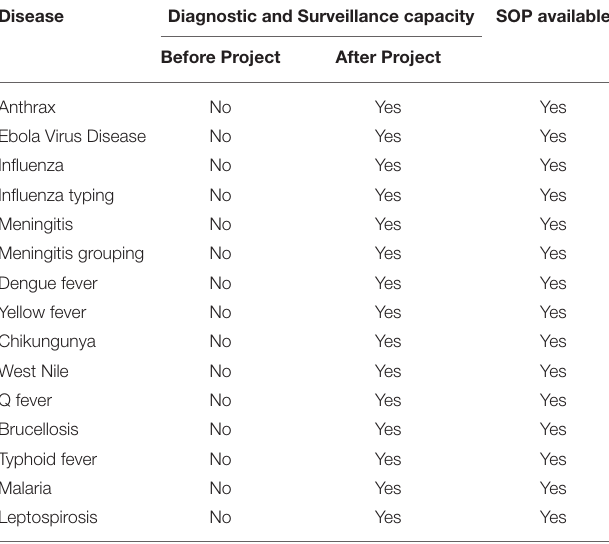
TABLE 1 | Diagnostic and surveillance capacity available at the INSP Nongo laboratory at the end of the project.